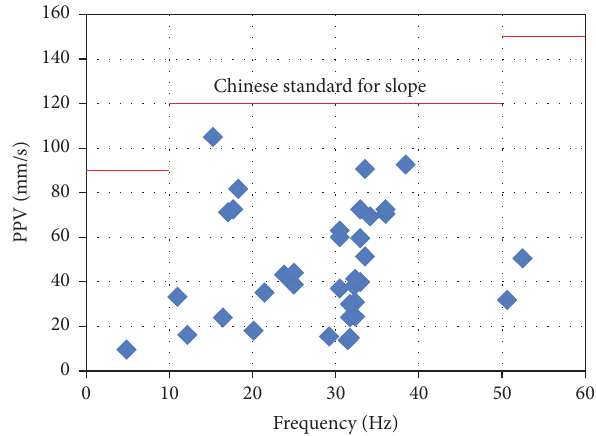
Figure 7: Representation of surface vibration in relation to Chinese